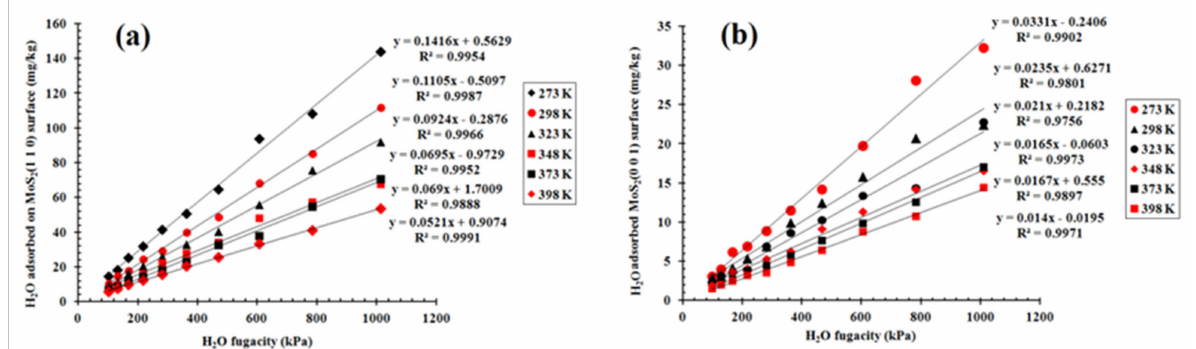
Figure 6. Sorption isotherm of H 2 O molecules on the ( a ): (001) and ( b ): (110) surfaces as a function of temperature.